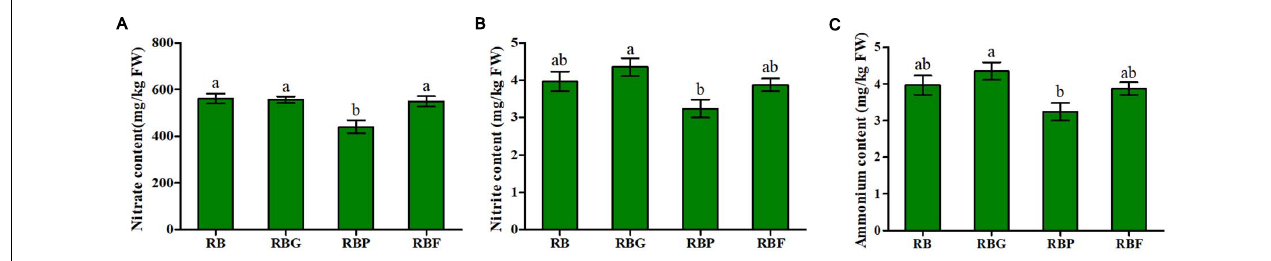
FIGURE 3 | Effects of spectra on nitrate (A) , nitrite (B) , and ammonium content (C) in lettuce leaves. RB, 75% red + 25% blue LED; RBG, 60% red + 20% blue + 20% green LED; RBP, 60% red + 20% blue + 20% purple LED; RBF, 60% red + 20% blue + 20% infrared LED. The letters represent the significant difference of different treatments ( p < 0.05).